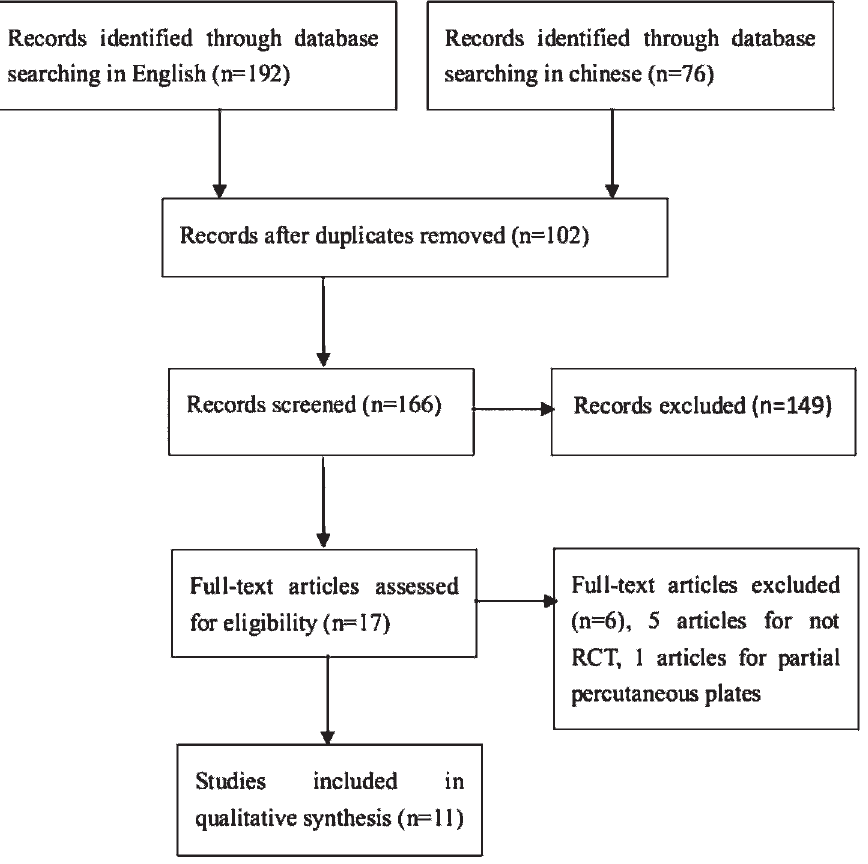
Figure 1 - Flow chart showing article